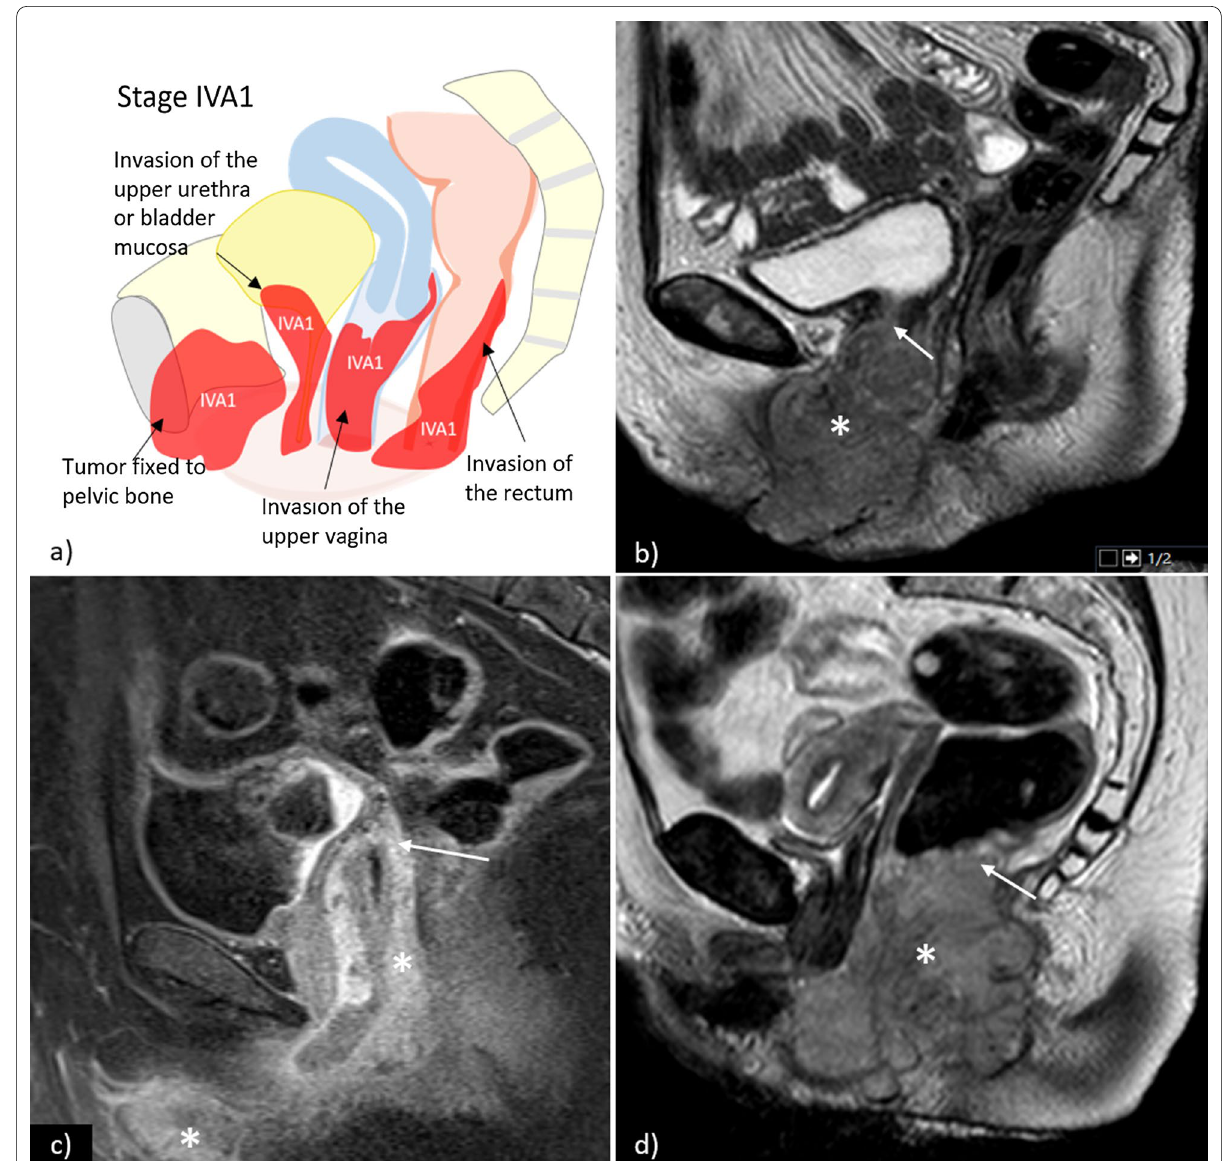
Fig. 9 a Schematic illustration of FIGO stage IVA1. Examples of stage IVA1 vulvar carcinomas (*) in different patients: b sagittal T2WI sequences shows vulvar tumour with invasion of the upper third of the urethra (arrow); c sagittal contrast‑enhanced T1WI sequence shows vulvar tumour with invasion of the upper third of the vagina (arrow); d sagittal T2WI sequences shows vulvar tumour with invasion of the rectum